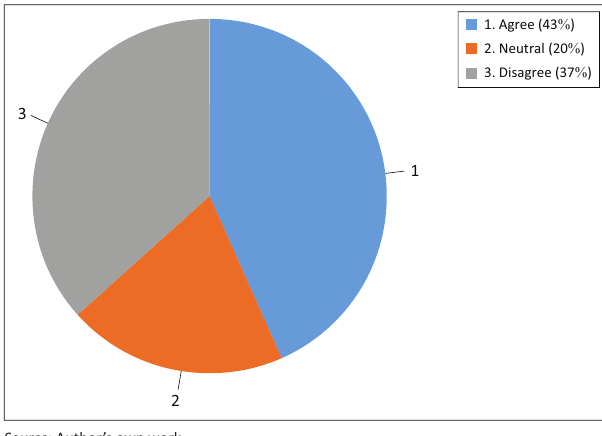
FIGURE 1: Languages spoken at home ( % ).